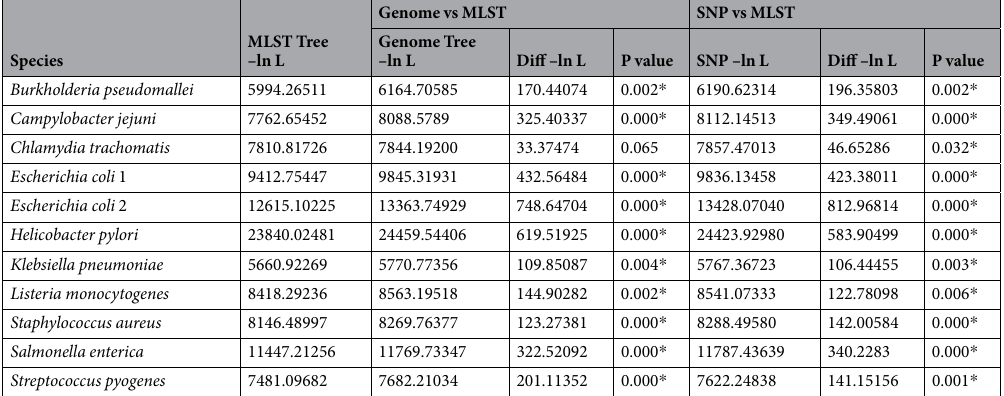
Table 2. Comparison by Shimodaira-Hasegawa test of log-likelihood scores between genome/SNP and MLST trees of the 10 bacterial species. * P < 0.05.